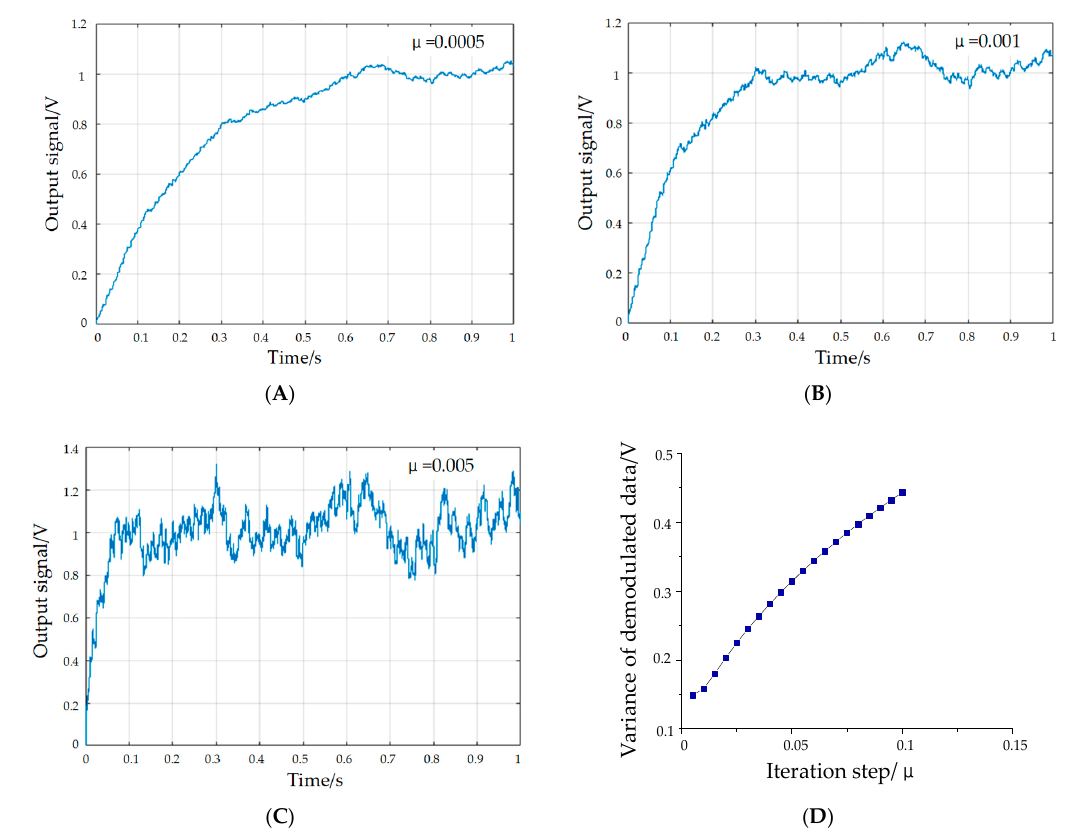
Figure 9. Amplitude curves of demodulation signals. ( A ) µ = 0.0005. ( B ) µ = 0.001. ( C ) µ = 0.005. ( D ) Effect of iteration step on convergence precision.